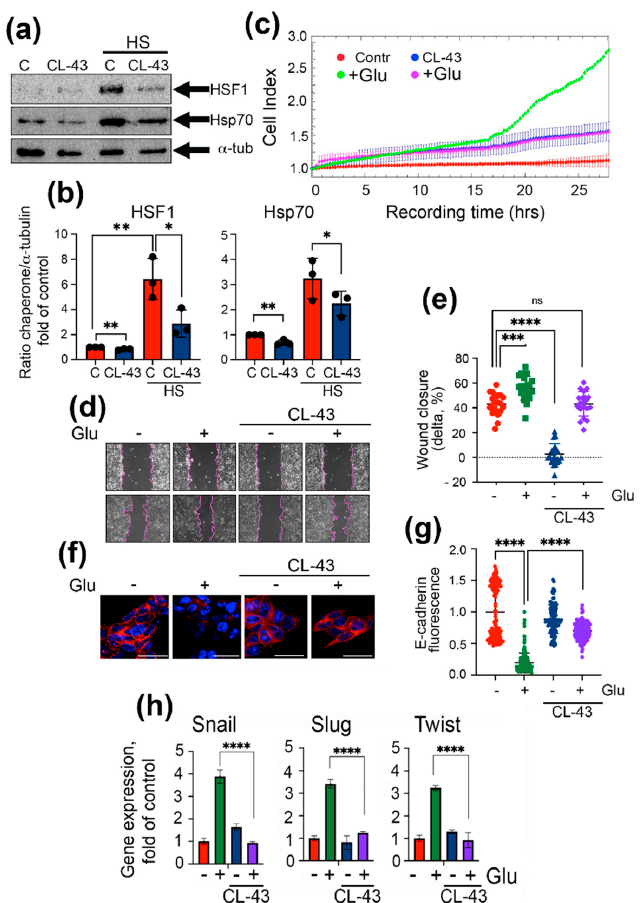
Figure 3. Inhibitor of master regulator HSF1 (CL-43) decreases cell motility and EMT markers expression in DLD1 cells. ( a ) Western blotting of DLD1 cells, controls and cells treated with 500 nM CL-43 before heat shock (43 ◦ C, 30 min, and 18 h of recovery) probed with antibody against HSF1, Hsp70 and α -tubulin (as a loading control). ( b ) Ratio of intensity of HSF1 or Hsp70 bands to band intensity of a-tubulin. Band intensity was measured with the aid of ImageJ. Data of three western blots were calculated. * p = 0.0212, 0.0442, ** p = 0.0020, 0.0080, 0.0015. ( c ) After 6 days of incubation with 80 mM glucose and 0.5 µ M CL-43, DLD1 cells were seeded to 16-well CIM plates and then monitored with the aid of xCELLigence equipment over 28 h. ( d ) Wound healing assay of DLD1 cells treated as in ( b ) with calculation ( e ) as the ratio of the distance of the overgrown area of the scratch at 24 h to the distance at 0 h after damage in 21 lines (delta). The distance was measured using the Adobe Photoshop CS6 program. Data are presented in % of delta. *** p = 0.0001, **** p < 0.0001 ( f ) E-cadherin expression in DLD1 cells treated with 80 mM glucose and 500 nM CL-43 revealed with